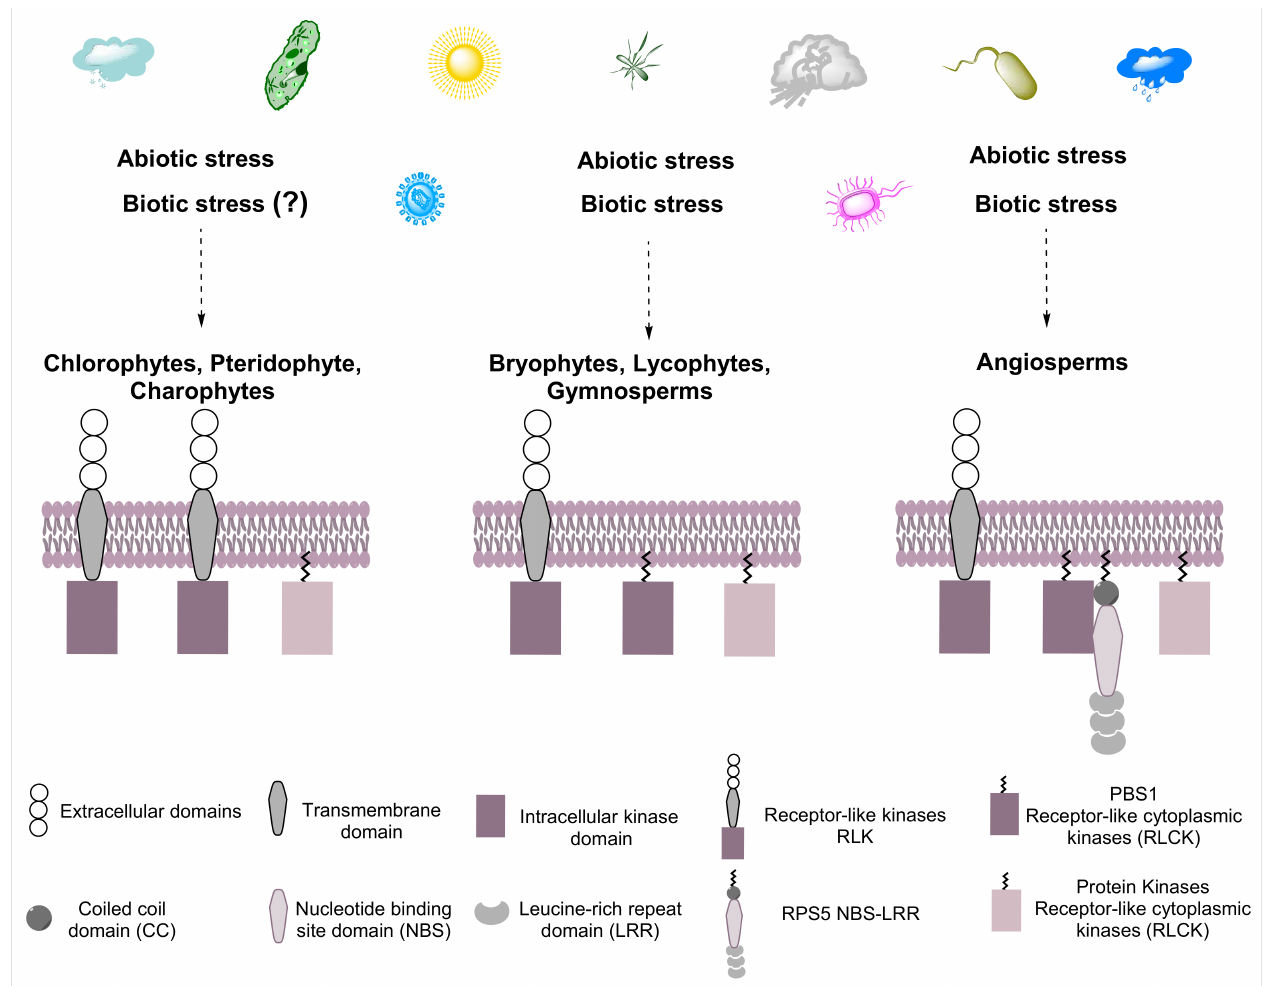
Figure 11. Hypothetical model for the evolution of PBS1. Plants are exposed constantly to biotic and abiotic stress, resulting in the evolution of systems that cope with such stress in streptophytes and chlorophytes. We suggest that PBS1 evolved from RLKs containing transmembrane domains in ancestral embryophytes and are related to those present in chlorophytes that would later become part of the plant immune system. The arsenal of microbial effectors is recognized by various response proteins, such as receptor-type kinases, among them PBS1, which participates in the defense response by activating RPS5 in angiosperms. Dotted arrows indicate towards which species the biotic and abiotic stresses will be caused. Question mark (?) indicates it is not known whether that biotic stress induces this